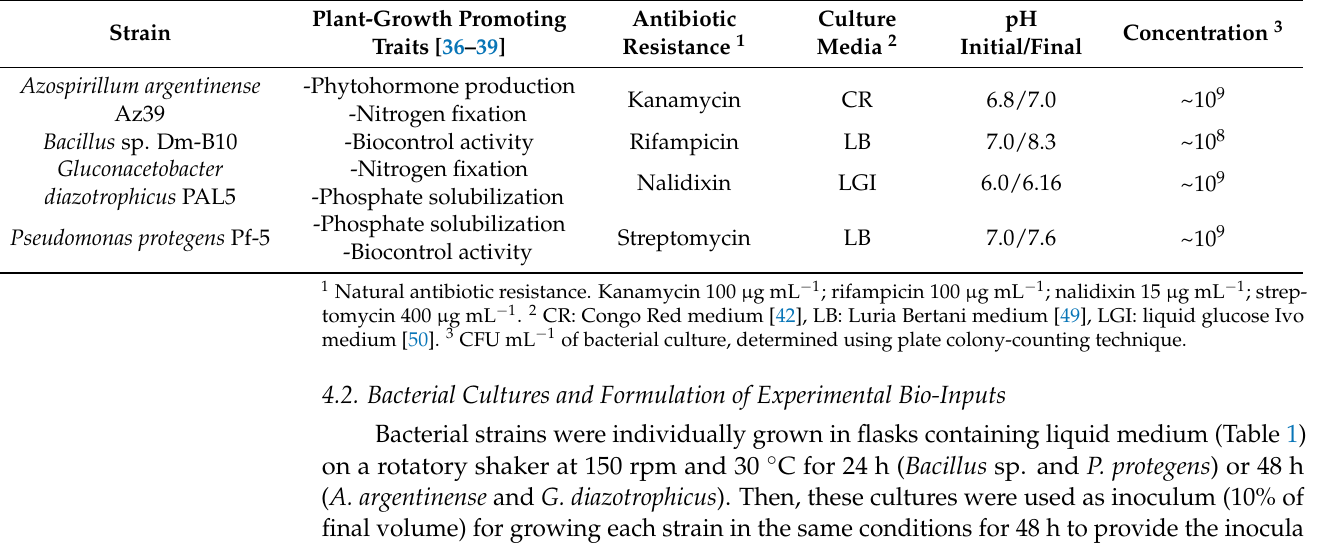
Table 2. PGPB traits, antibiotic resistance, culture media final pH, and concentrations of bacterial